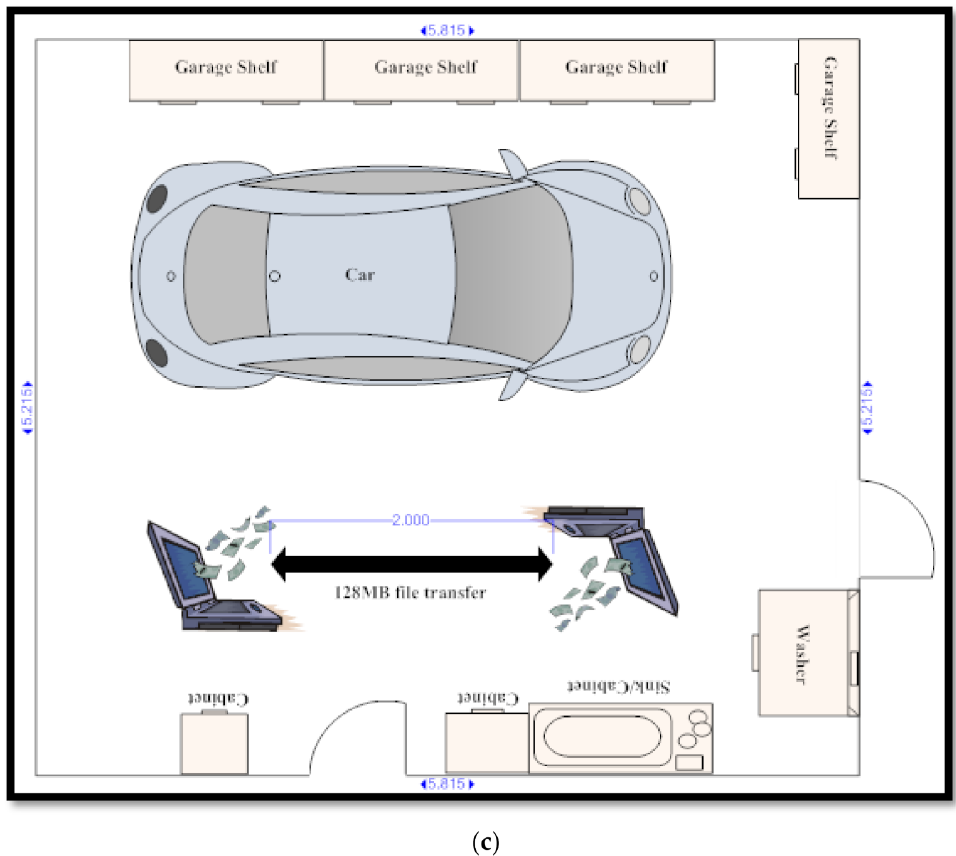
Figure 3. Floor plan for a suburban residential home showing lounge, bedroom, and garage. ( a ) Lounge; ( b ) Bedroom; ( c )